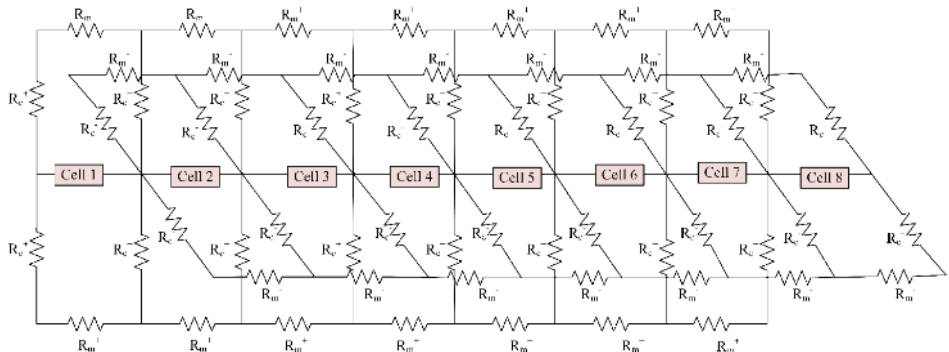
Figure 51. An equivalent circuit model of ZnBr batteries; the resistances of the positive and negative electrolyte are represented by Rm+ and Rm-, respectively. Rc+ and Rc- represent the resistance of the positive and negative electrolyte in the channel [153].